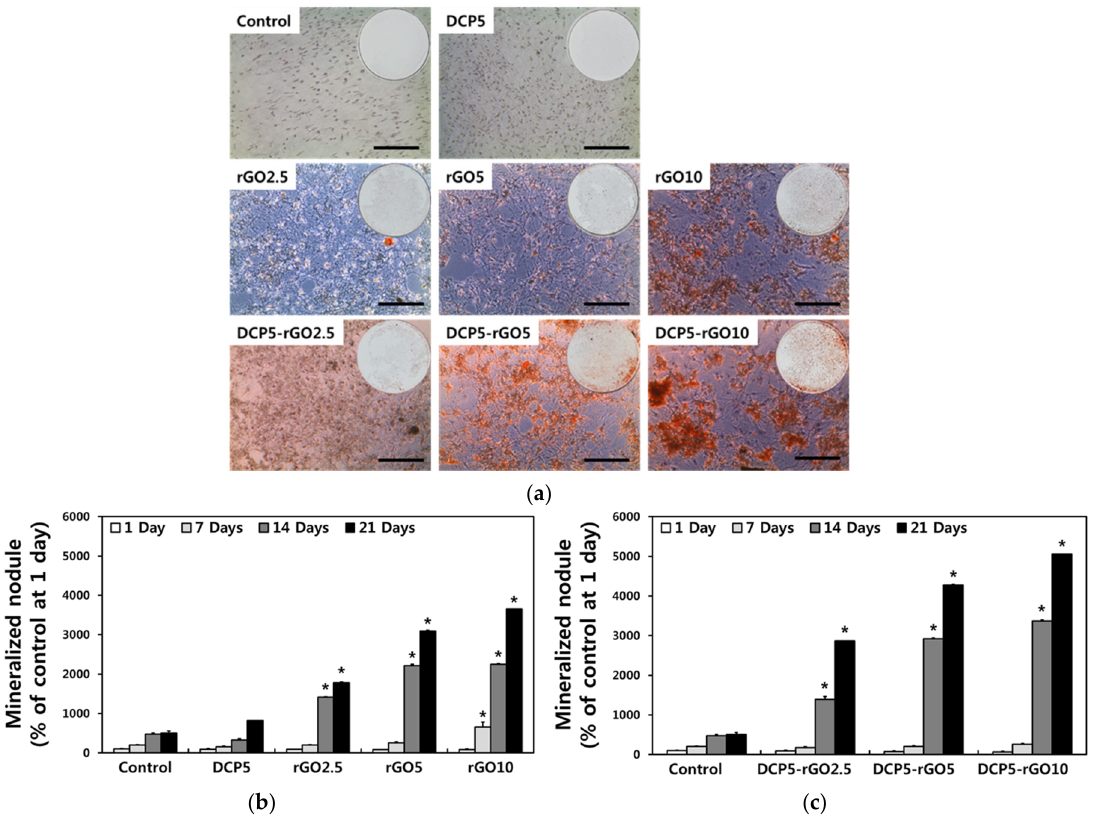
Figure 6. Effects of DCP ‐ rGO hybrid composites on calcium mineralization. ( a ) ARS staining images of MC3T3 ‐ E1 cells treated with DCP, rGO, and DCP ‐ rGO hybrid composites. Scale bars are 200 μ m. ( b ) Quantification of ARS extracts in MC3T3 ‐ E1 cells treated with 5 μ g/mL of DCP or 2.5, 5 and 10 μ g/mL of rGO. ( c ) Quantification of ARS extracts in MC3T3 ‐ E1 cells treated with DCP ‐ rGO hybrid composite. Cultures with fresh media were used as the negative control. An asterisk (*) denotes a significant difference when compared with the control, p < 0.05.